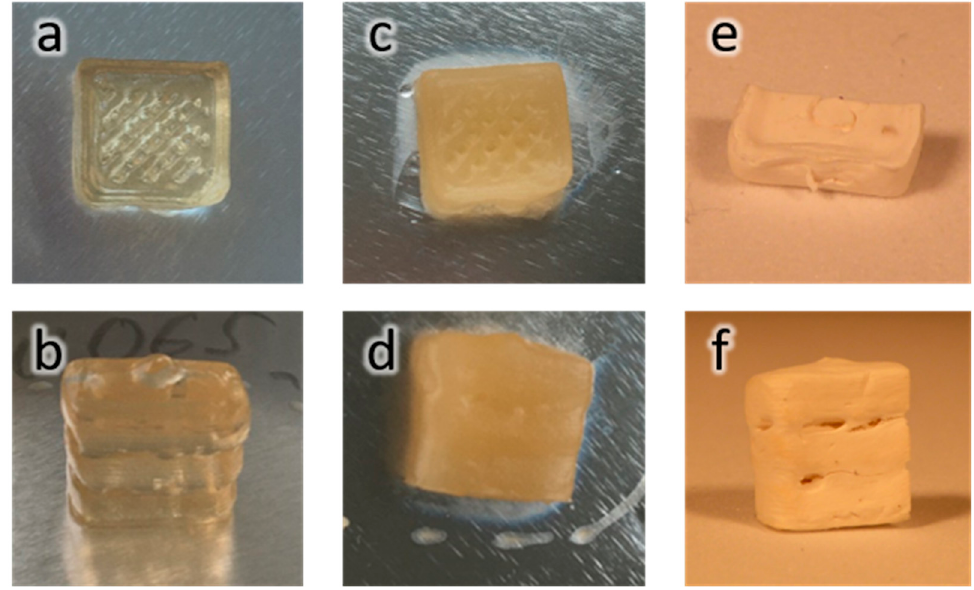
Figure 9. Photos of 3D printed cubes from CNF–PSA–CFO in toluene (10 wt%). The upper row shows the 10 × 10 × 5 mm cube printed on its 10 × 10 mm surface; the lower row was printed on its 5 × 10 mm surface. ( a , b ) Toluene gel after printing, ( c , d ) DMSO ‐ based gel after the solvent exchange, and ( e , f ) freeze ‐ dried cubes (cut open for electron microscopy).